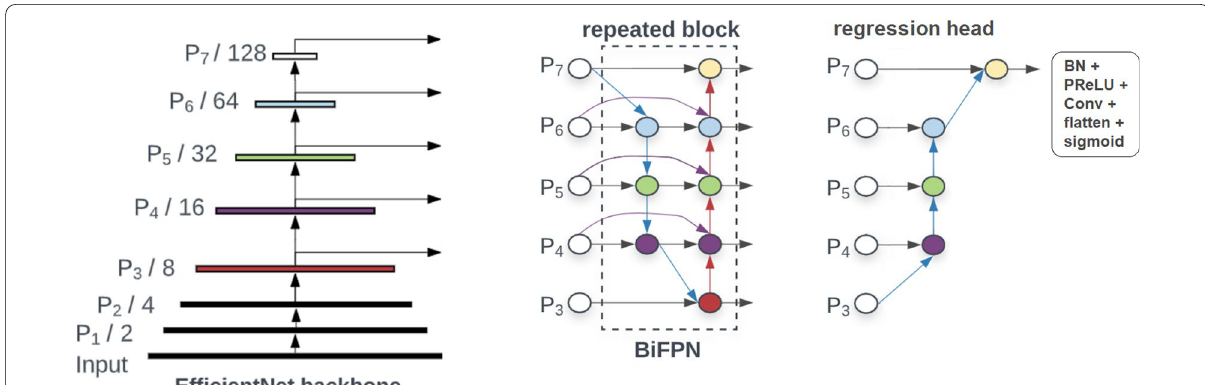
Fig. 2 Network architecture. An EfficientNet B0 backbone is connected to three repeated bidirectional feature pyramid blocks (BiFPNs). The regression head consists of serially connected fast normalized fusion nodes and finally BatchNorm (BN), PReLU, a single‑channel convolution, and a sigmoid activation. Numbers indicate the resolution at each level relative to the input. Image adapted from [35]